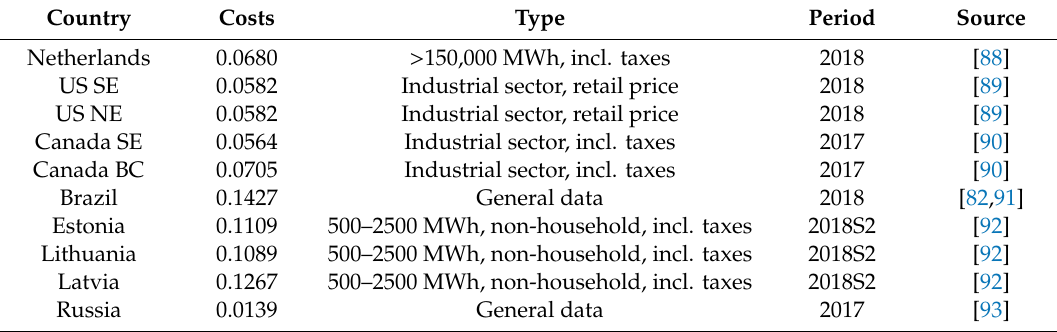
Table A4. Grid electricity costs used in this study, in € / kWh.